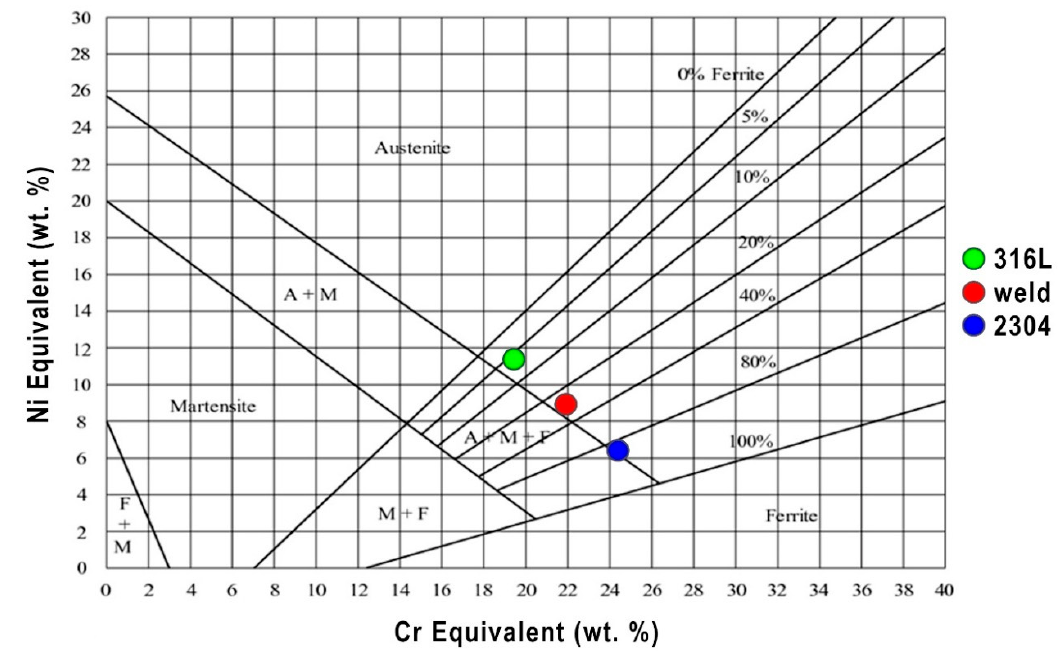
Materials 2020 , 13 , x FOR PEER REVIEW Figure 11. Schae ffl er constitutional diagram. Figure 11. Schaeffler constitutional diagram.